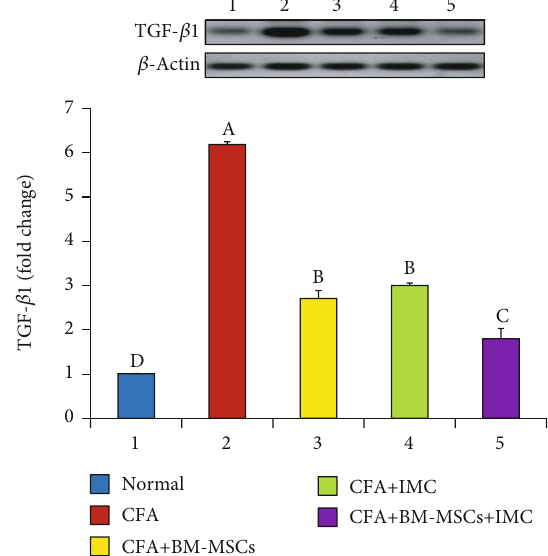
Figure 8: E ff ect of BM-MSCs and/or IMC on the TGF- β 1 level in CFA-induced rats. Means, which have di ff erent symbols, A, B, C, and D, are signi fi cantly di ff erent at p < 0 : 05